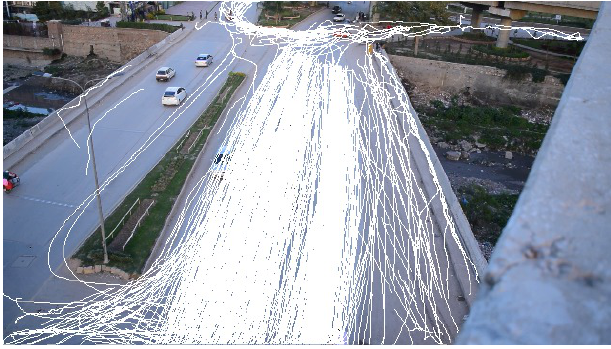
Figure 11. The vehicle trajectories on a 50 m road University Road section over a period of 1442